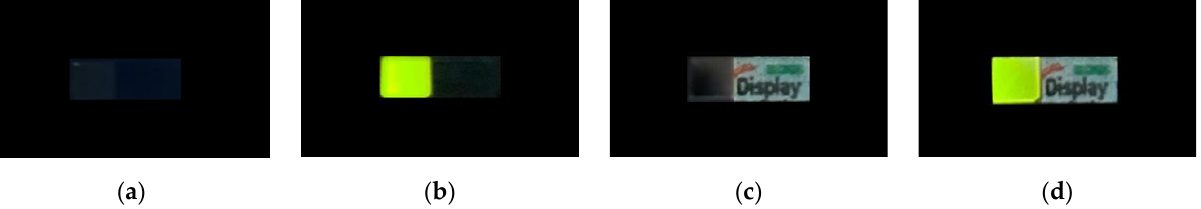
Figure 12. Fabrication and operation of non-polarized mode transparent OLED display is ( a ) when OLED and LCD are dark state, ( b ) when only OLED is bright state, ( c ) when only LCD is bright state, ( d ) when all is bright state.